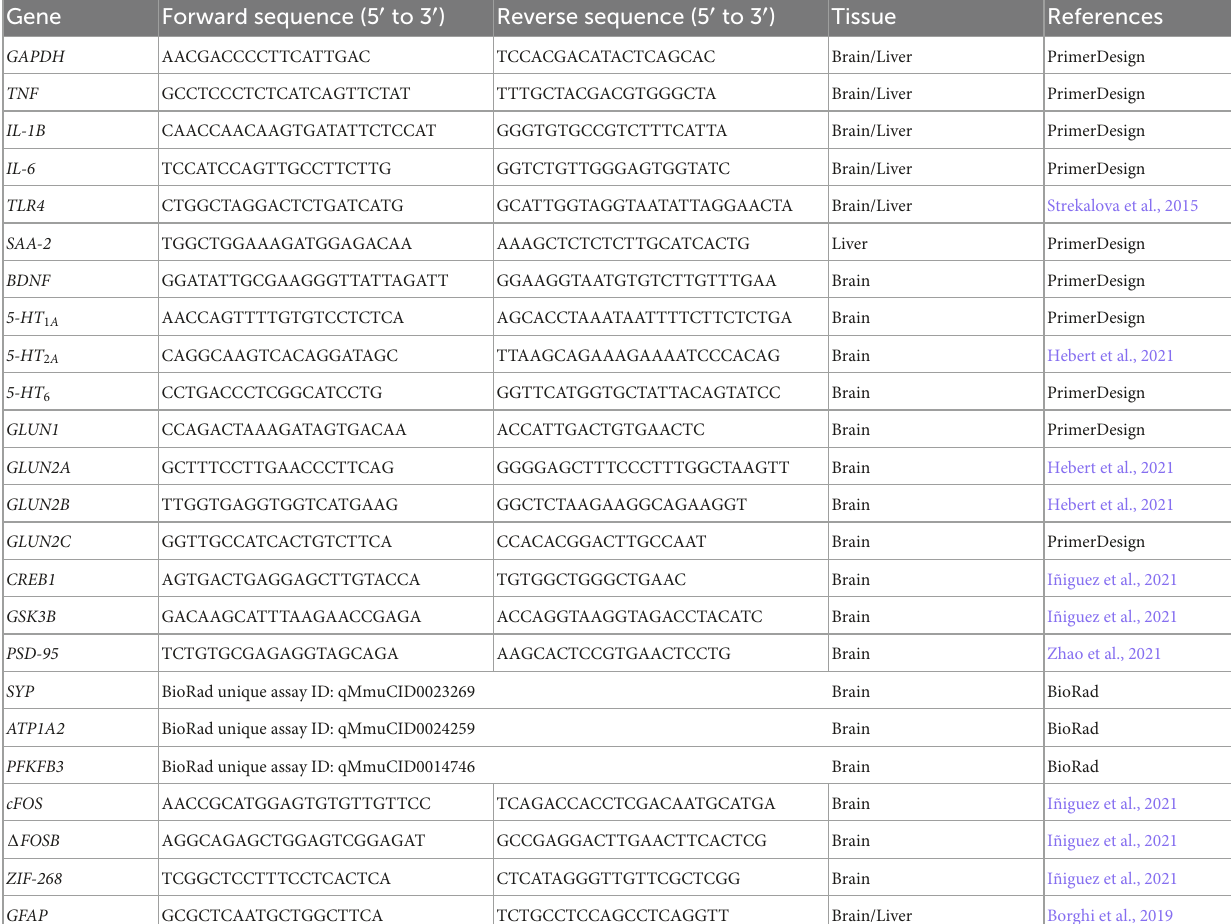
TABLE 1 List of primers for qPCR. Gene Forward sequence (5 (cid:48) to 3 (cid:48)